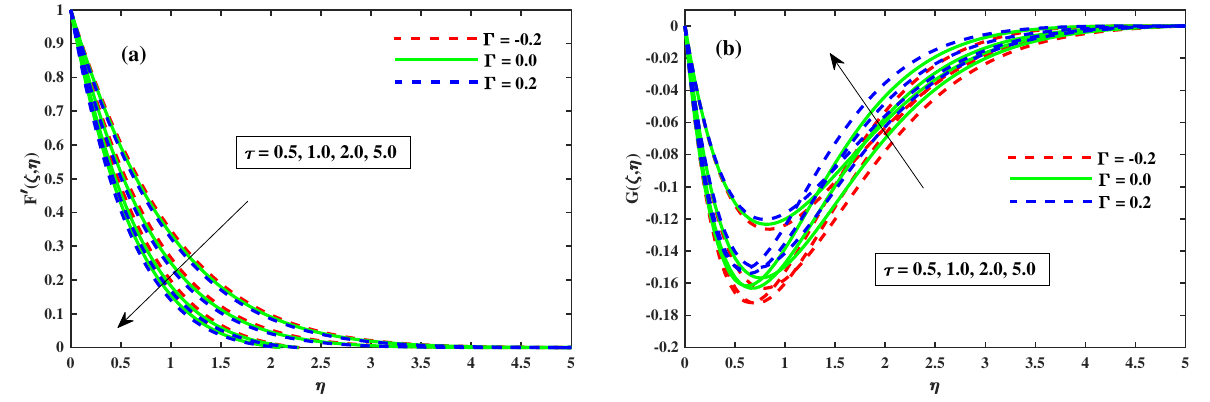
Figure 4. Influence of τ on G along y-direction in ( b ) and F (cid:48) along x-direction in ( a ) when ζ = 1.